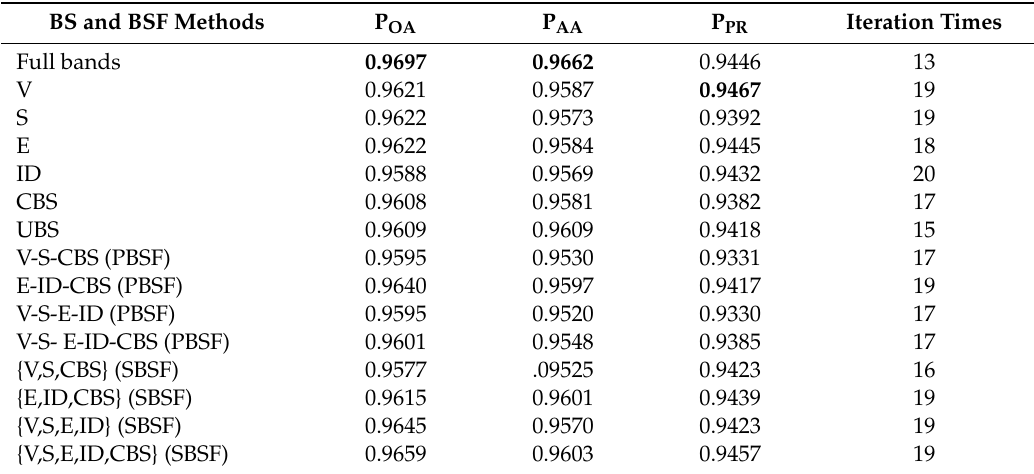
Table A3. P OA , P AA , P PR and the number of iterations calculated by ICEM using full bands and bands selected in Table 7 for Salinas data.